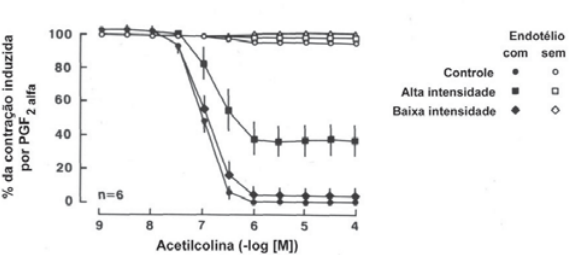
Fig. 4 - Relaxamento dependente do endotélio induzido por acetilcolina (Ach) em artérias coronárias caninas. As artérias foram expostas à baixa ou alta intensidade de energia ultra-sônica e contraídas com prostaglandina F contração induzida pela PGF apresentados como médias ± erro padrão médio e observaram- se diferenças estatisticamente significantes (n = 6,